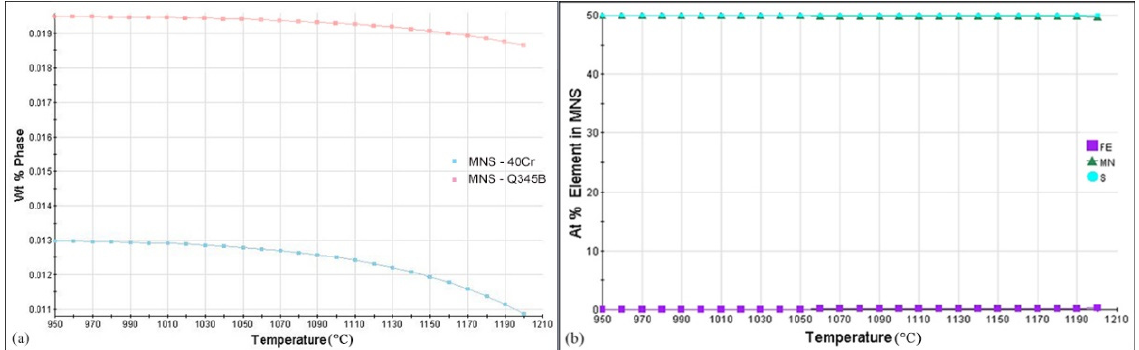
Figure 3. The MnS weight fractions ( a ) and the MnS element constitutions ( b ) in 40Cr and Q345B at temperatures between 950 and 1200 °C.